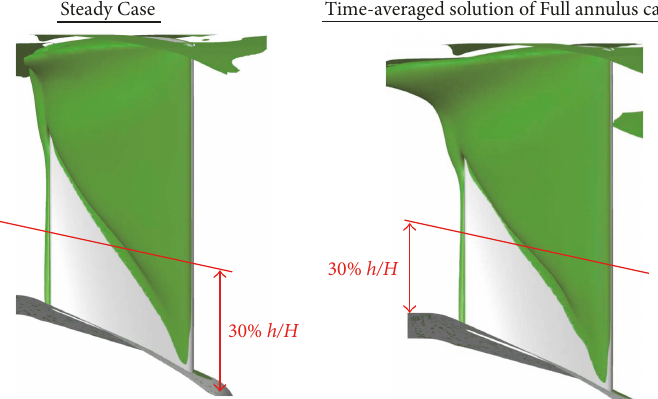
Figure 10: Numerical rotor zero axial velocity isosurface.